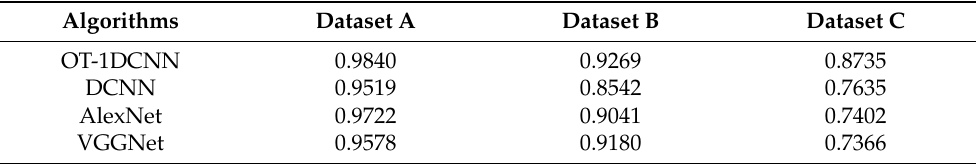
Table 8. The results of comparative experiments with the self-made dataset.